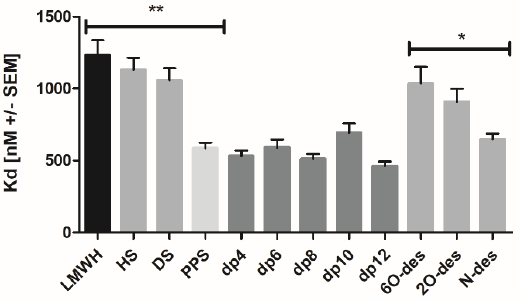
Figure 4. Mean Kd values of ACE2 to different GAG variants (compound abbreviations: see Figure 3; * p < 0.05, ** p < 0.01 was considered as statistically significant.